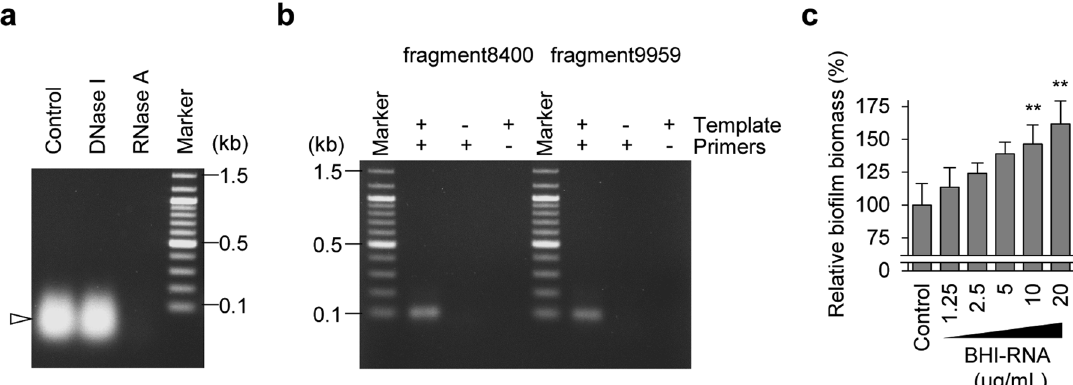
Fig. 3 RNA from the surrounding milieu affects bio fi lm formation. a Nucleic acids were isolated from BHI medium via ethanol precipitation, treated with DNase I and RNase A or left untreated (Control), and detected on an agarose gel. A white arrowhead denotes RNA. b The presence of RNA identi fi ed by RNA-seq was con fi rmed by reverse transcriptase-polymerase chain reaction using RNA puri fi ed from the BHI medium as a template and primers speci fi c for the fragments identi fi ed through RNA-seq (Supplementary Table 1). + added, − not added. c The effects of the RNA puri fi ed from BHI medium (BHI – RNA) on the formation of MR10 bio fi lms in Roswell Park Memorial Institute medium supplemented with 1% glucose. The data are presented as the mean and standard deviation (error bar) of relative bio fi lm biomass from